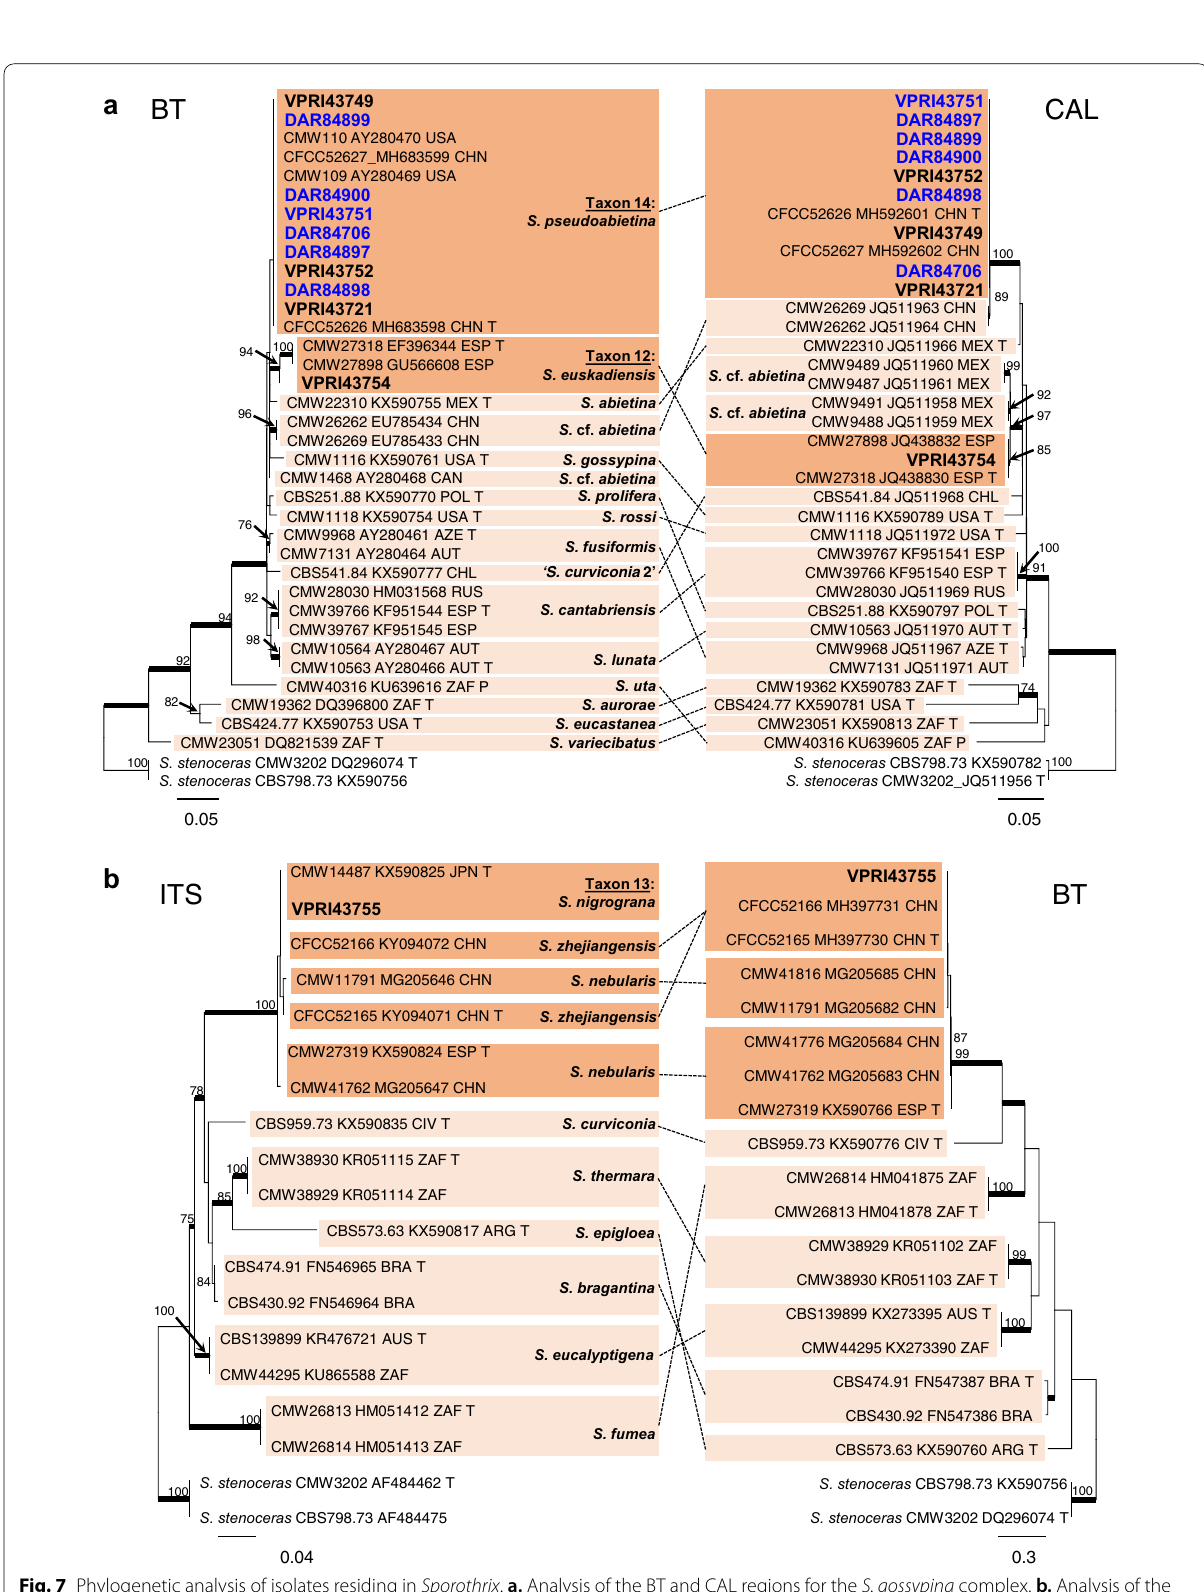
Fig. 7 Phylogenetic analysis of isolates residing in Sporothrix . a. Analysis of the BT and CAL regions for the S. gossypina complex. b. Analysis of the ITS and BT regions for Sporothrix ‘Group G’. Sequences generated in this study are printed in bold, with reference collection isolates coloured blue. Bold branches indicate posterior probability values